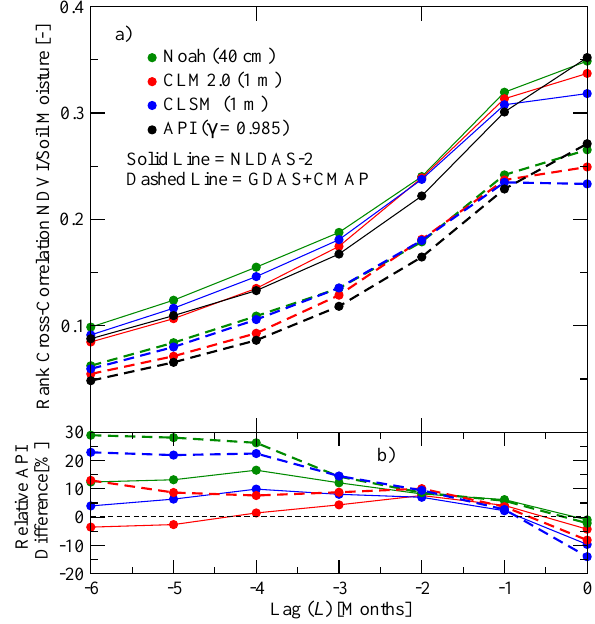
Fig. 7. CONUS land averages of (a) R(L) for Noah, CLM2.0, CLSM, and API root-zone soil moisture predictions based on ei- ther the GDAS+CMAP or NLDAS-2 forcing datasets, and (b) percentage relative R(L) percentage difference for the modern LSMs (Noah, CLM2.0, and CLSM) versus an API baseline (i.e., 100 ·[ R(L) LSM − R(L) API ] /R(L) API )